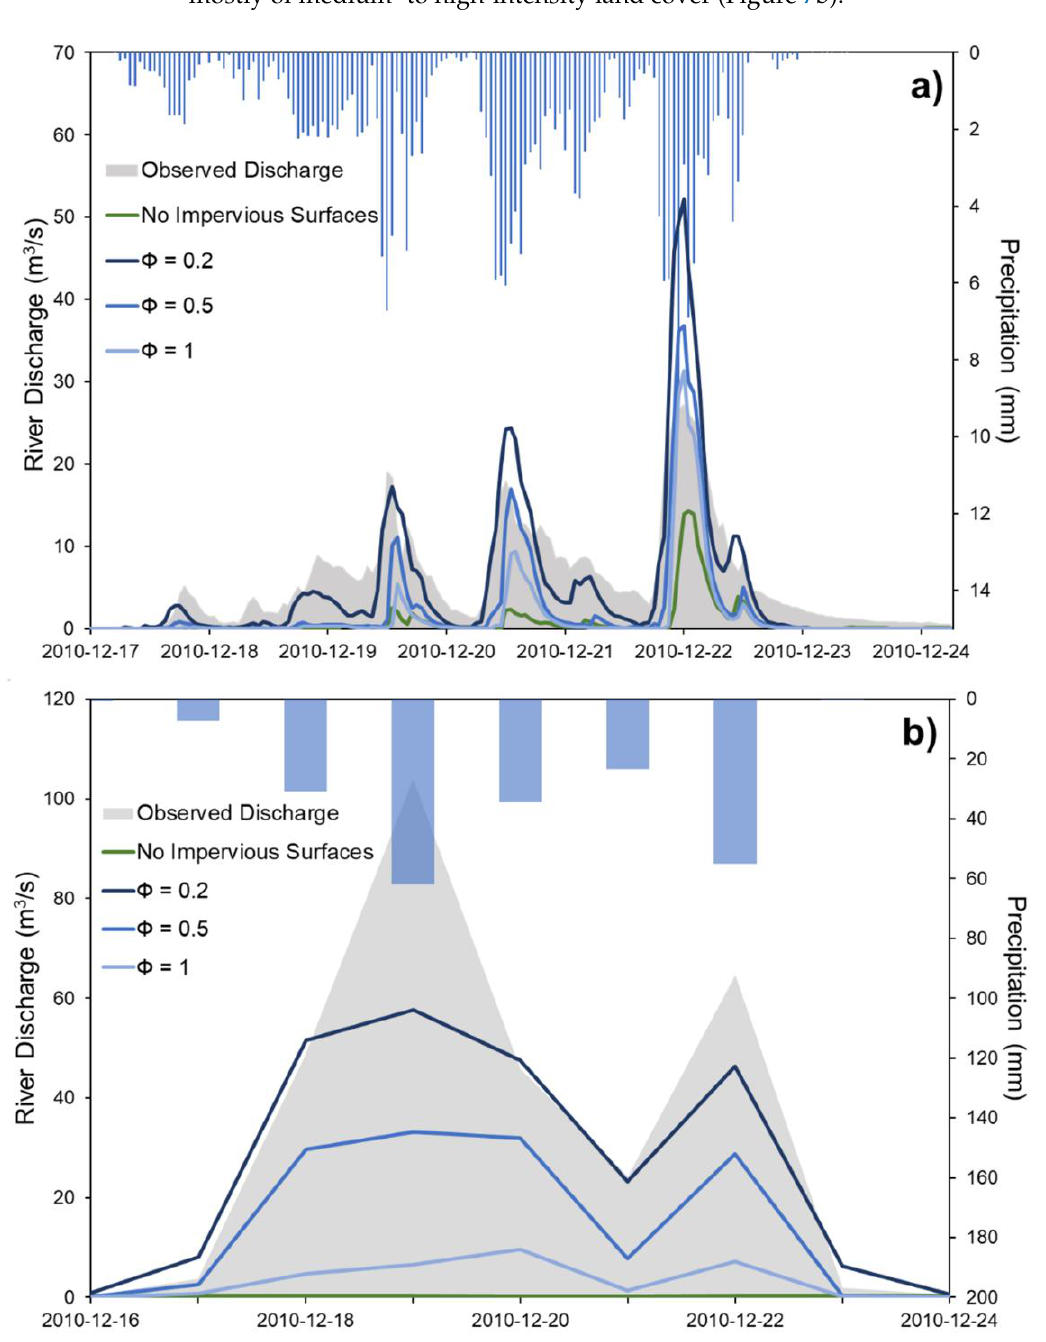
Figure 7. Observed and simulated hydrographs at ( a ) Brea Creek (hourly), and ( b ) Ballona Creek (daily) with and without impervious surfaces. The lower the scaling parameter Φ , the more the impact of TIAs on surface runoff is amplified.